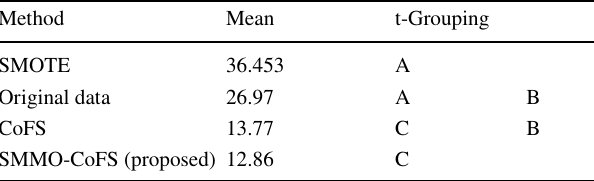
Table 10 The result of a statistical significance t test in terms of